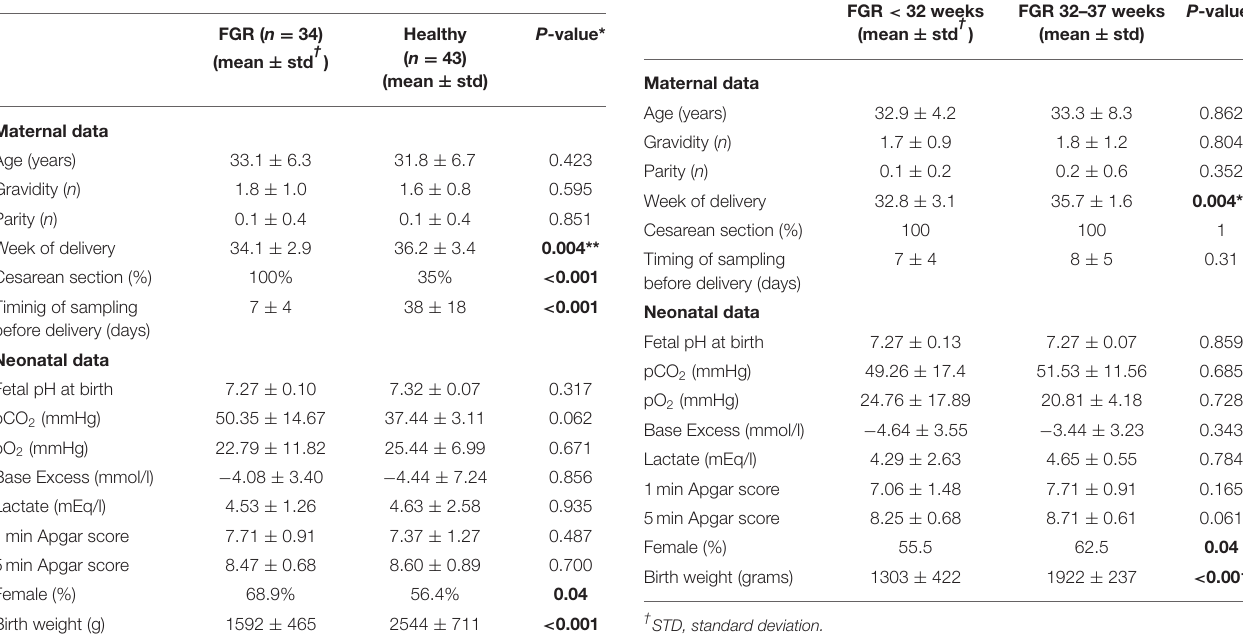
TABLE 1A | Maternal and neonatal data comparison between FGR and Healthy groups.